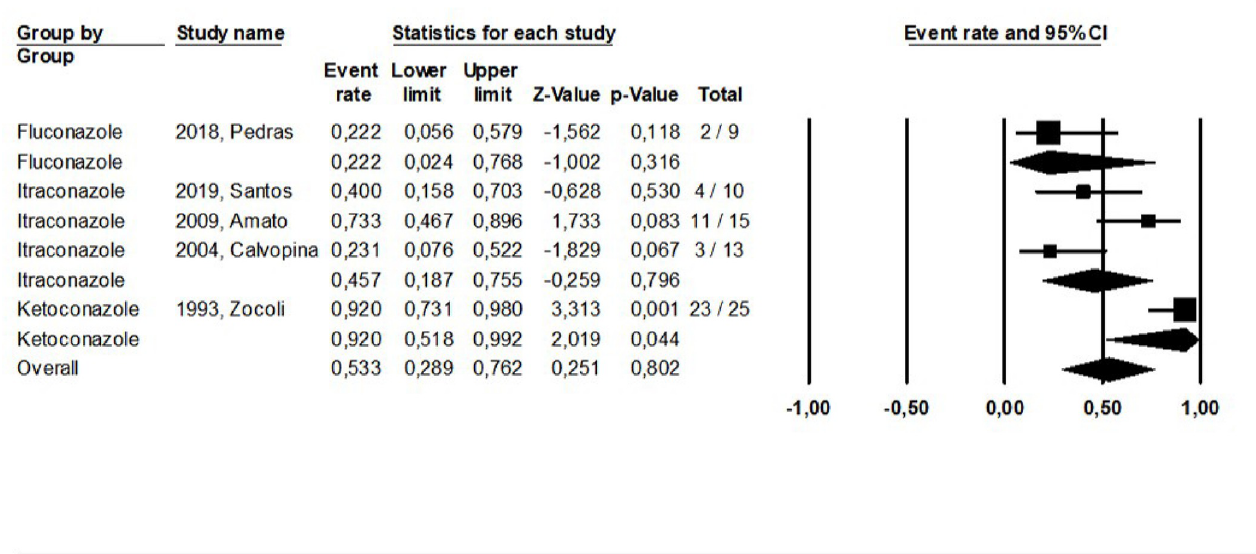
Fig 7. Pooled cure rate including all patients treated for ML with imidazole drugs in the reviewed studies using a mixed effect analysis.